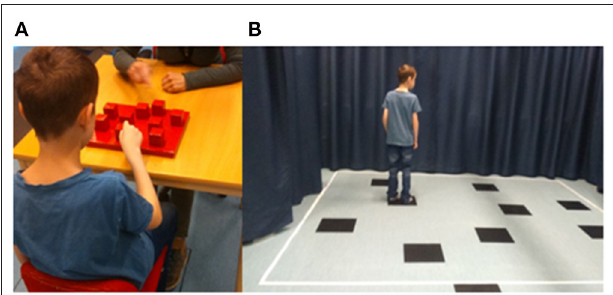
FIGURE 1 | (A) Apparatus used to administer the Corsi block-tapping test (CBT). The CBT consists of nine wooden blocks (4.5 × 4.5cm) fixed on a baseboard (30 × 25cm). Numbers are only present on the examiner’s side, not visible to the child. (B) The walking Corsi test (WalCT) is a larger version of the CBT (300 × 250cm) consisting of nine squares placed on the floor in identical positions as in the